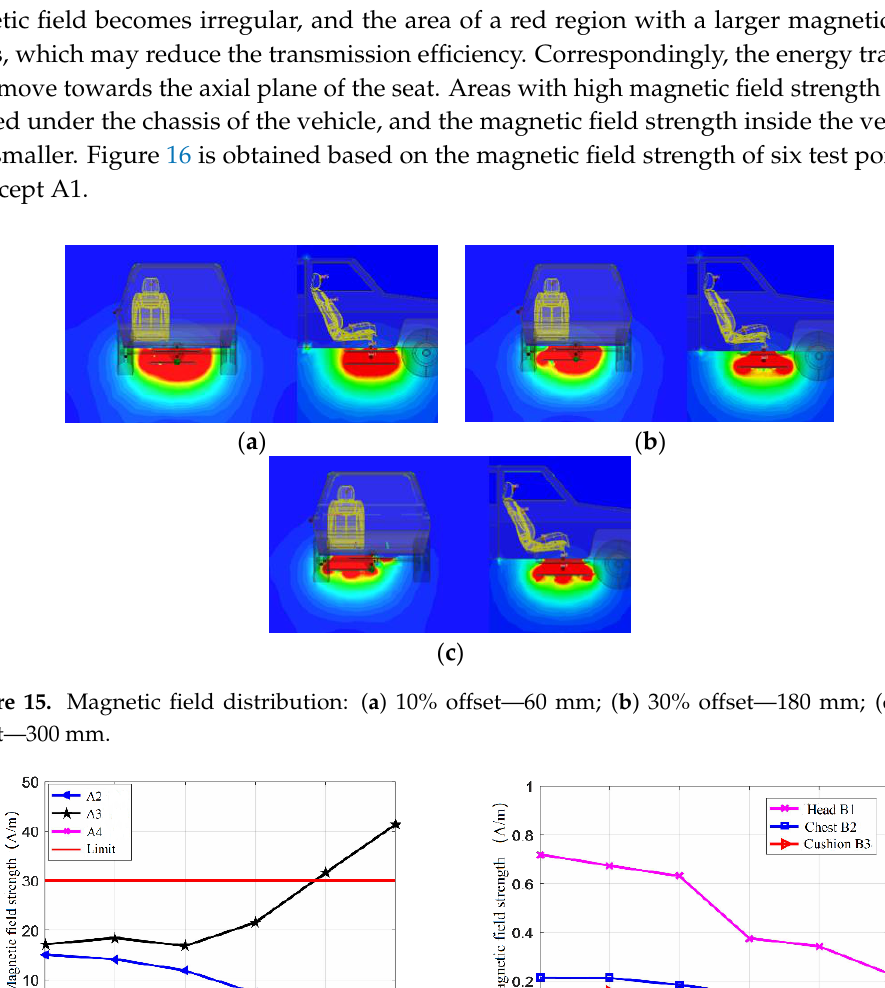
( b ) Figure 14. Phase of the primary current: ( a ) phase of the primary current at test point A3; ( b ) relationship between the offset and the phase of the maximum magnetic field. Similarly, the five phases with various offsets can be obtained, and the primary current phase corresponding to the maximum magnetic field is shown in Figure 14b. The principle of coupling shows that as the offset increases, the primary current phase of the maximum magnetic field is different, which shows an increasing trend within the offset range. The simulation of magnetic field distribution is based on the current phase corresponding to the maximum magnetic field.